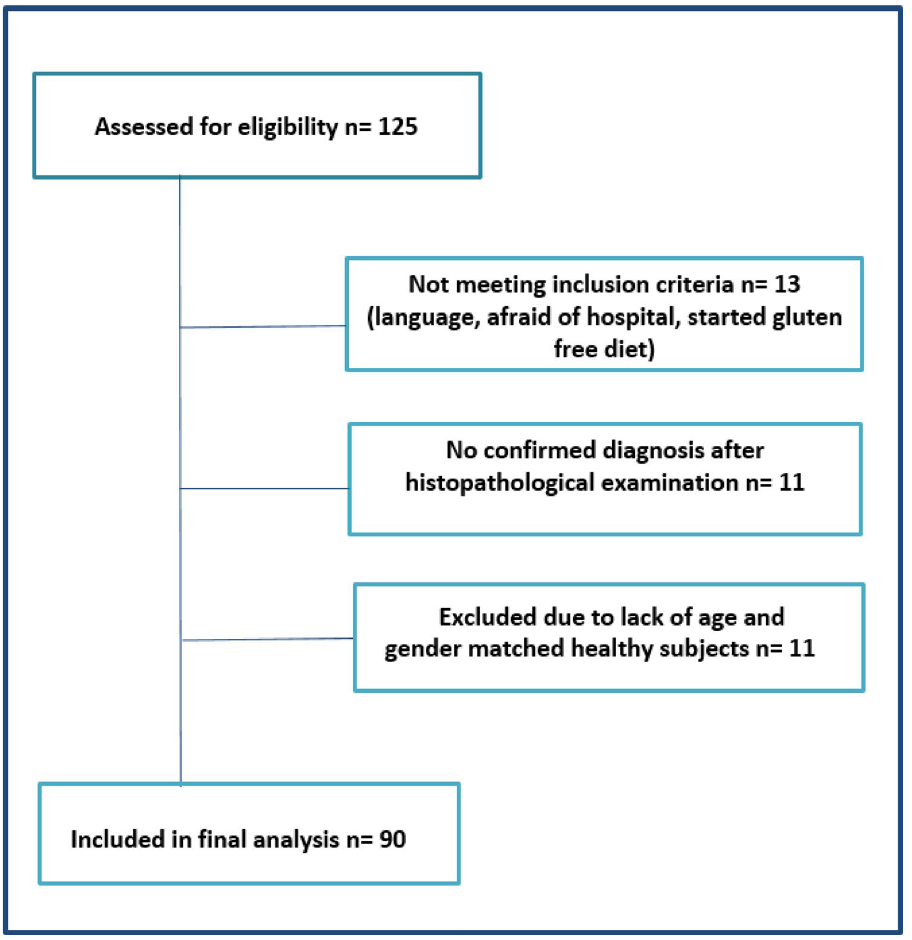
Figure 1. Flowchart of patient